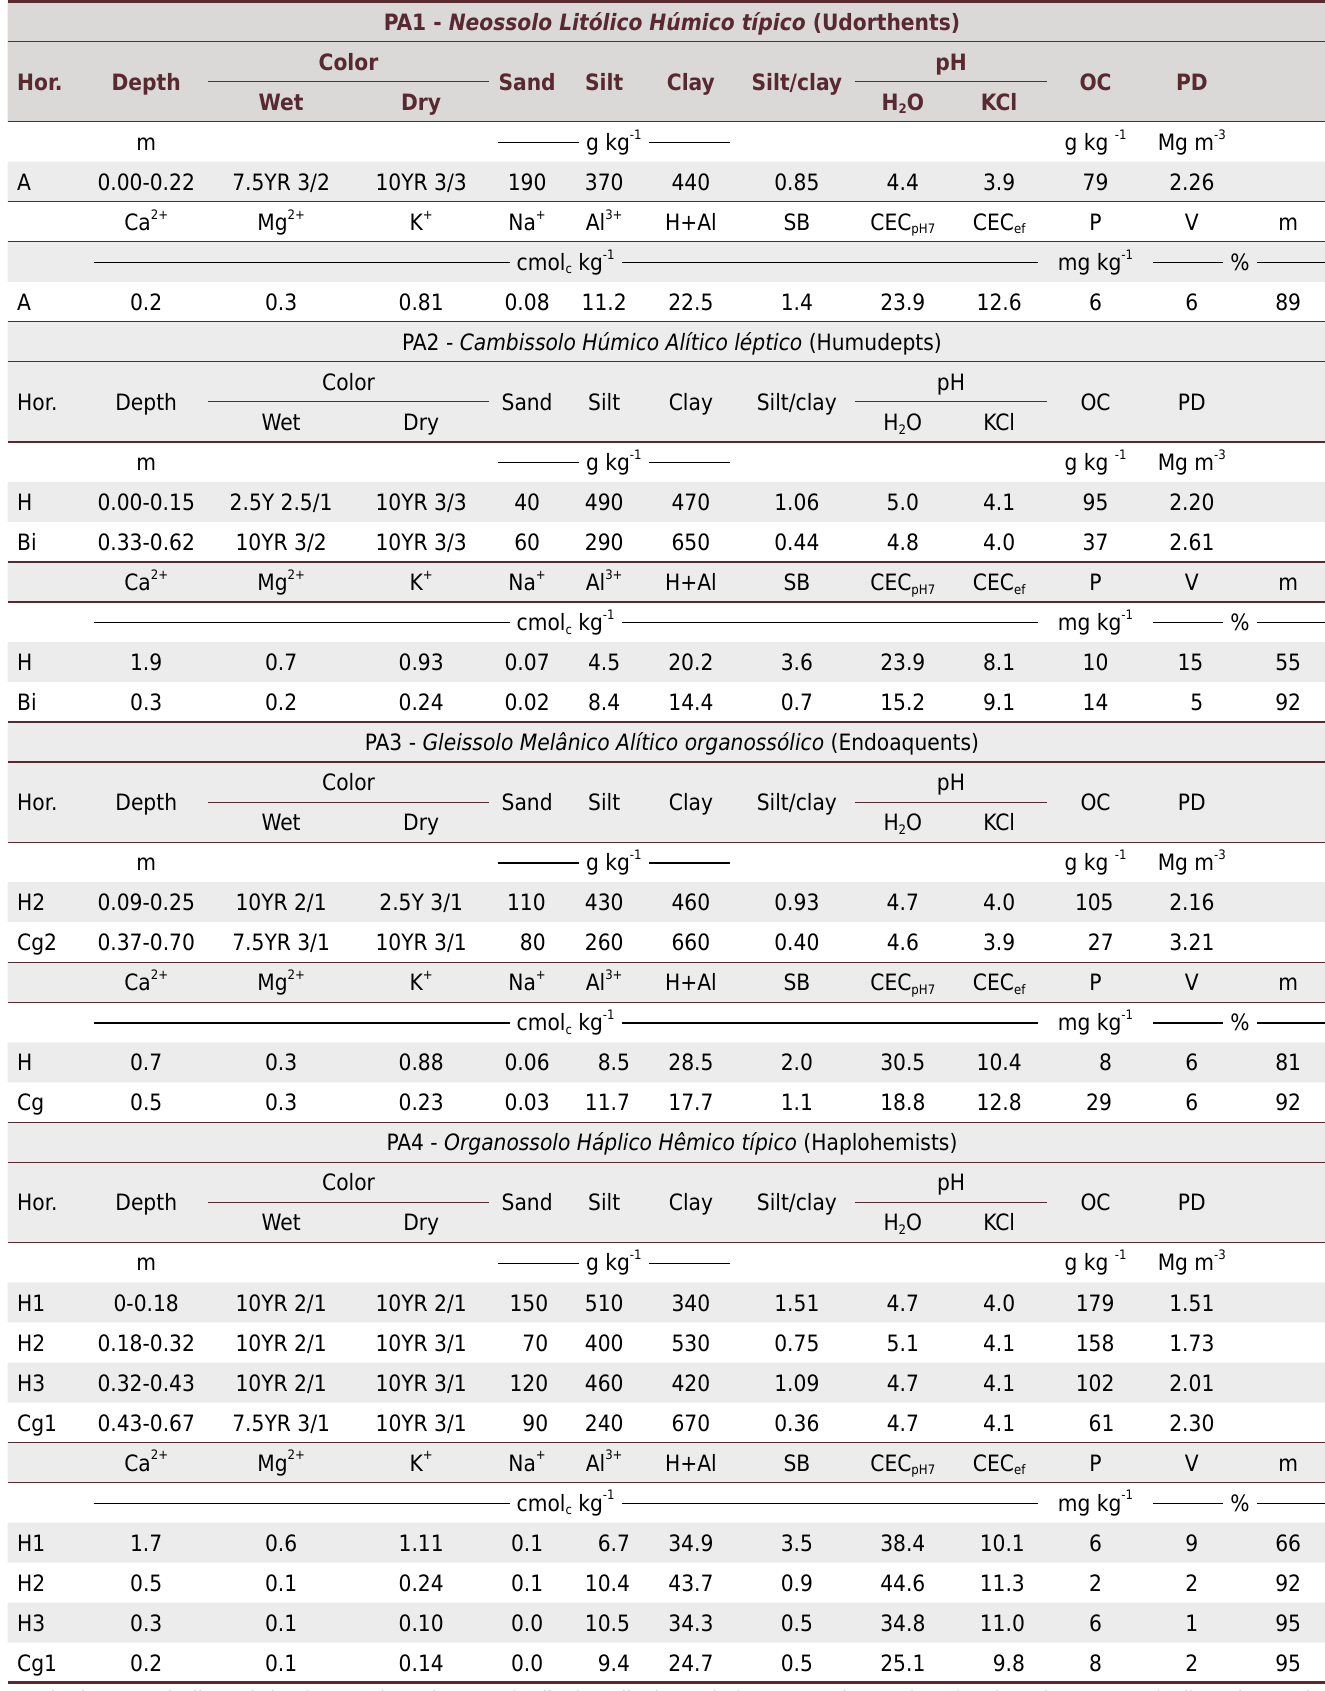
Table 3. Morphological, physical, and chemical properties of the soils collected in the wetland of Painel (PA), SC, Brazil PA1 - Neossolo Litólico Húmico típico (Udorthents)